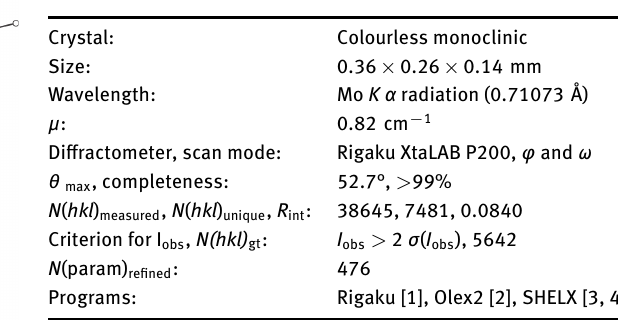
Table 1: Data collection and handling.